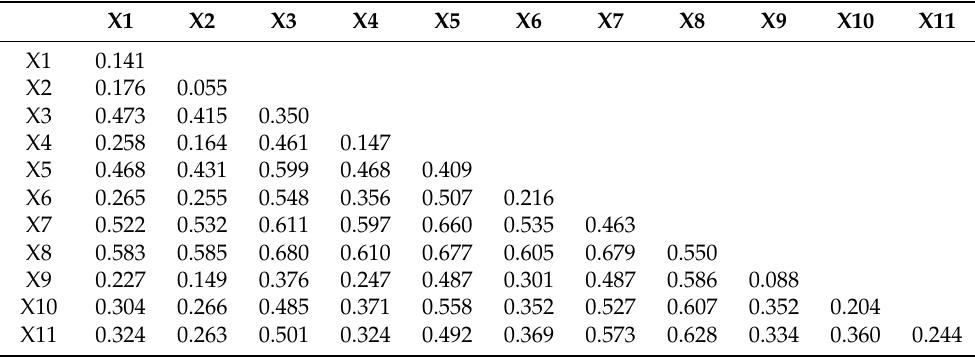
Table 7. Interaction detection of factors.